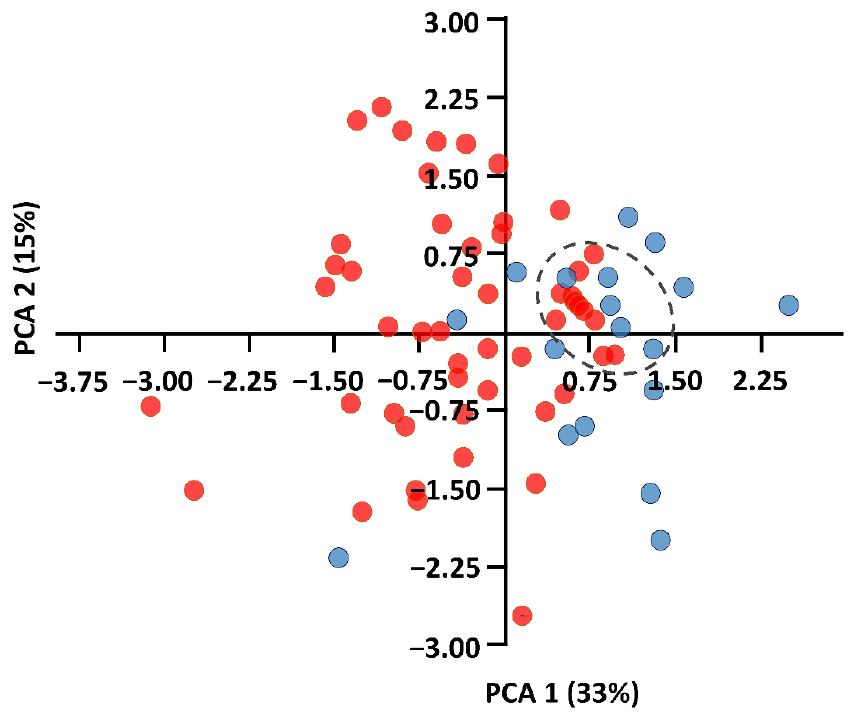
Figure 2 . PCA scatterplot of the first two axes (PC1 and PC2) of 51 individuals of P . auritus (red) and 26 individuals of P . austriacus (blue) based on 15 measured external characters. Percentage of total variance associated to each PC is provided in parentheses. Among the measured individuals of P. auritus (red), 10 males show a high degree of similarity among each other and in relation to some individuals of P. austriacus (dotted circle).